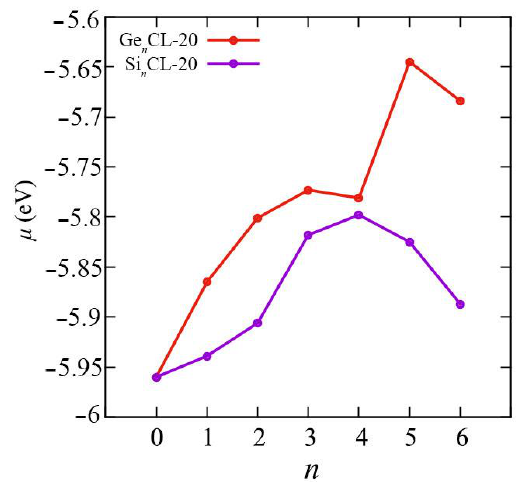
Figure 7. The chemical potential µ versus the number of Si-/Ge-atoms n in the Si n CL-20/Ge n CL-20 molecules for the most thermodynamically stable configurations obtained at the DFT/B3LYP/6- 311(d,p) level of theory.